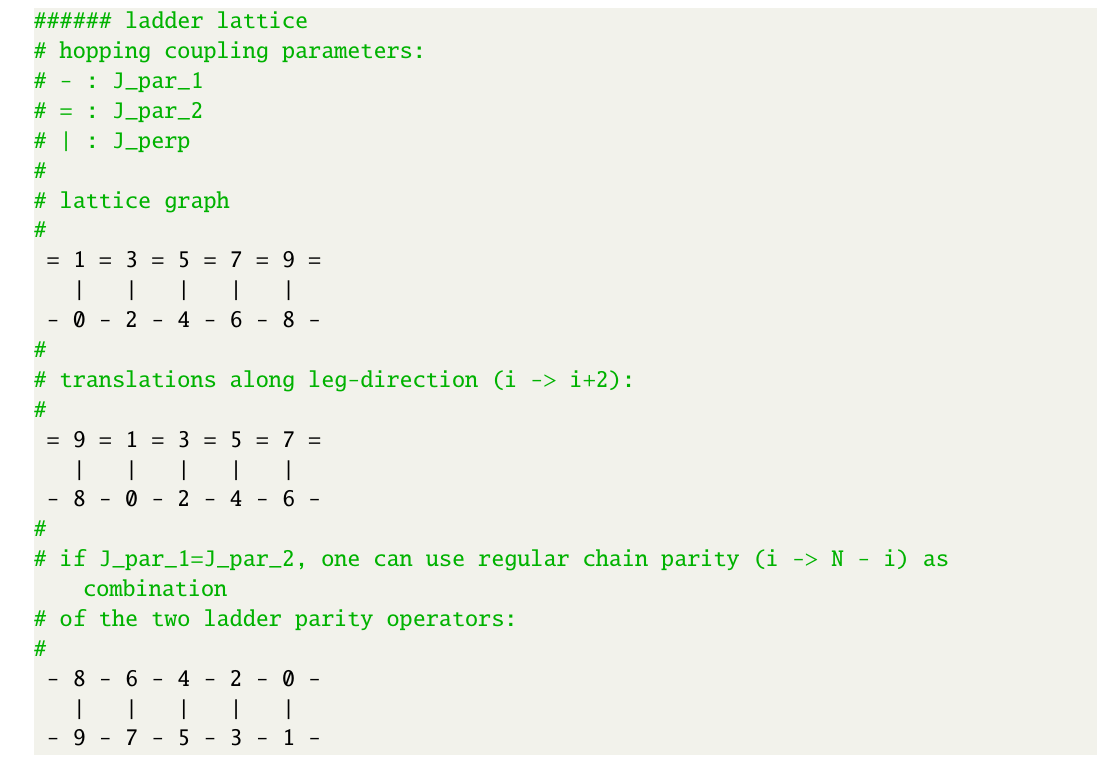
Code Snippet 1: Translationally Invariant Ladder Graph and its